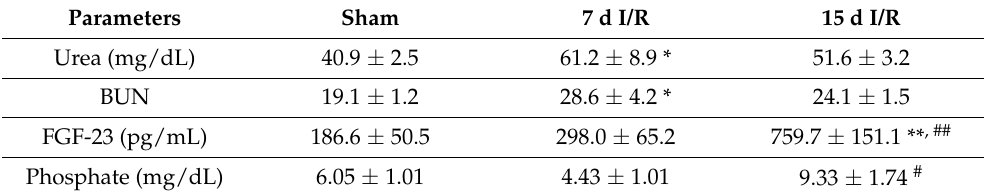
Table 2. Biochemical parameters in the ARF model 7 and 15 days following renal ischemia and